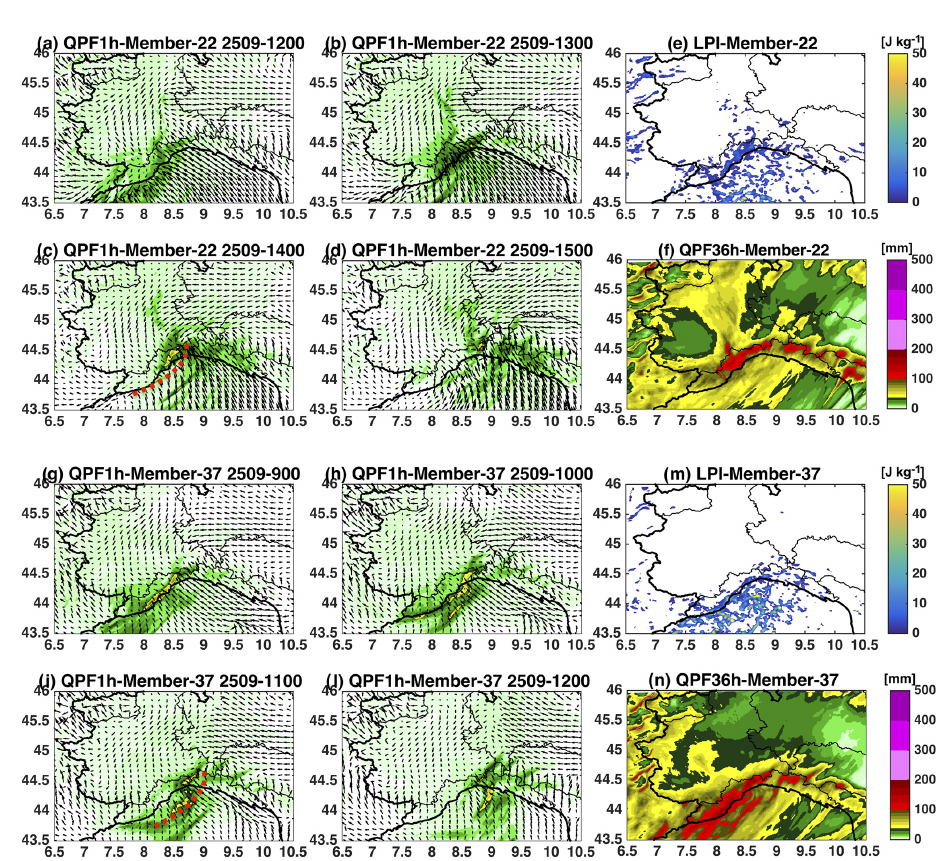
Figure 11. Panels (a–d) and (g–l) show the hourly QPF and 10m wind fields corresponding to the period with the minimum divergence values in Fig. 9 for members 22 and 37 (the convergence line trace in the most active phase is red dashed). Panels (e–f) and (m–n) show the Lightning Potential Index accumulated over the same 4h period and the 36h QPF respectively for members 22 and 37.